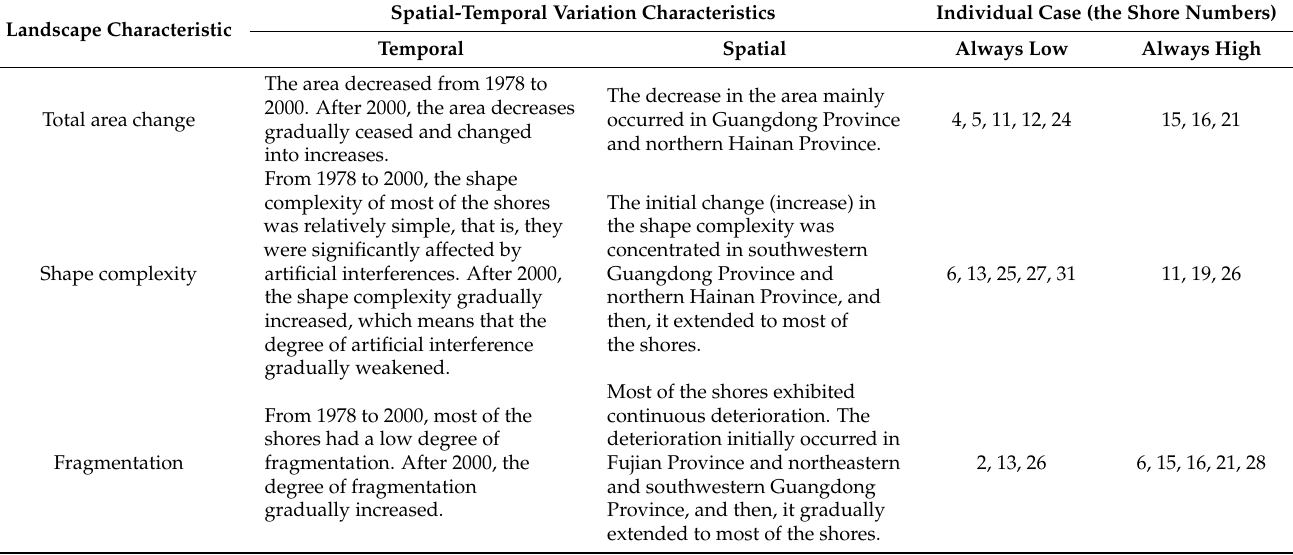
Table 10. Temporal and spatial variations in the mangrove landscape pattern in China over the last 40 years. Spatial-Temporal Variation Characteristics Individual Case (the Shore Numbers) Landscape Characteristic Temporal Total area change